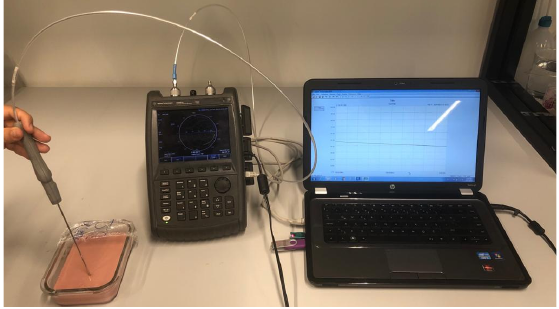
Figure 2. Phantom material and measurement